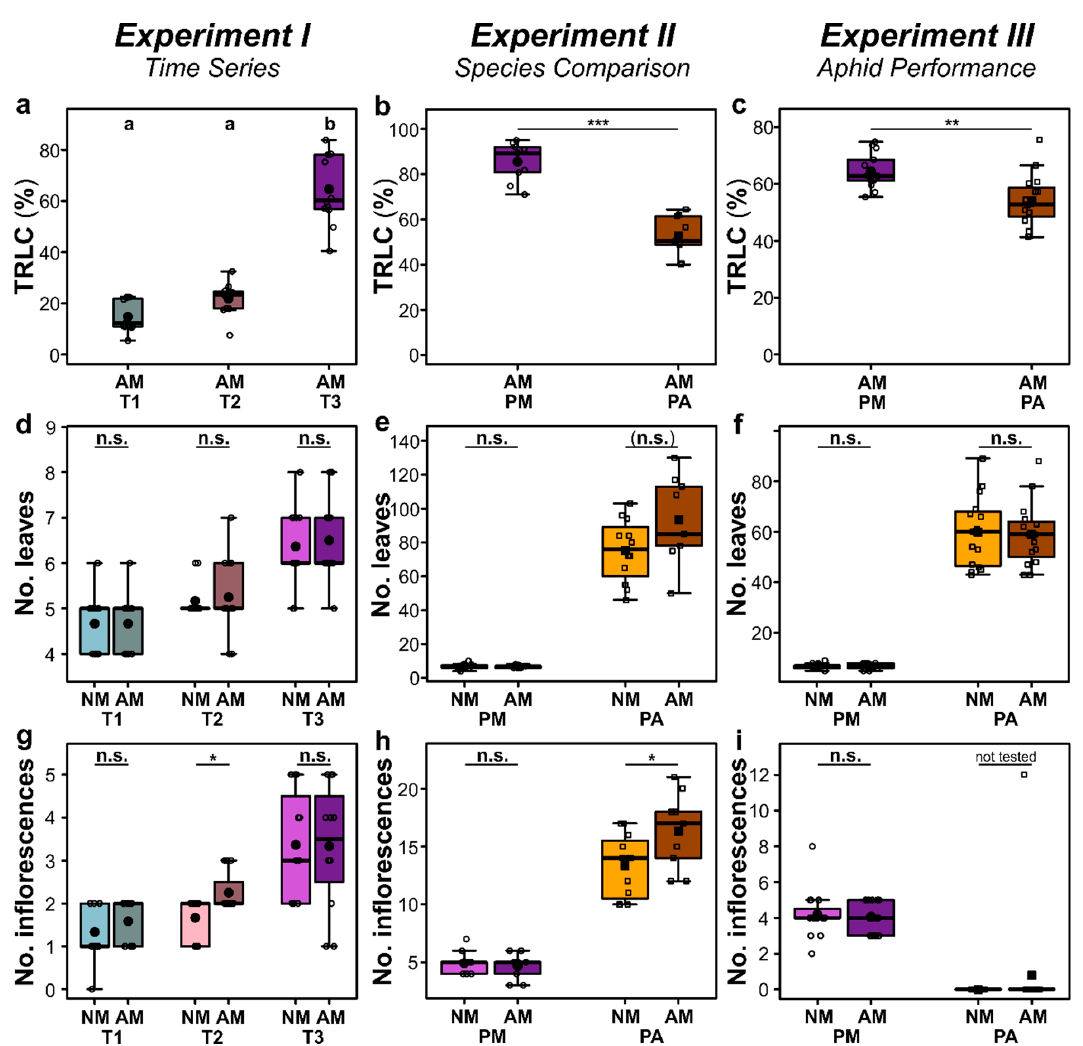
Figure 1. Total root length colonization (TRLC, first row), number of leaves (second row), and number of inflorescences (third row) of Plantago major (PM) and Poa annua (PA) plants that that have been left as controls (NM) or were inoculated with the arbuscular mycorrhizal fungus Rhizoglomus irregulare (AM). ( a , d , g ) Experiment I ( Time Series ) with P. major , showing data at the time points T1, corresponding to 20 days post inoculation (dpi), T2 (30 dpi), and T3 (63 dpi); ( b , e , h ) Experiment II ( Species Comparison ) with P. major and P. annua at 66–68 dpi (TRLC) and 64 dpi (numbers leaves/inflorescences); ( c , f , i ) Experiment III ( Aphid Performance ) with P. major and P. annua , showing TRLC at time points when all aphids had died on the individual plants or when the experiment was terminated, and numbers of leaves/inflorescences at 61 dpi (i.e., shortly before the aphid bioassay started). Data are given as box-whisker plots, with the medians given as horizontal thick lines, means as large filled symbols (circles: P. major ; squares: P. annua ), interquartile ranges (IQR) as boxes, raw data points as small open symbols (circles: P. major ; squares: P. annua ), and the whiskers extending to the most extreme data points within maximum 1.5 times the IQR. At the top of each subpanel, results of statistical tests are given: ( a ) different letters indicate significant differences of a post hoc Kruskal–mc test at p < 0.05, ( b – i ) asterisks indicate significant differences between groups [n.s., not significant; (n.s.) p < 0.1; *, p < 0.05; **, p < 0.01; ***, p < 0.001; ( b , c , f ) t -tests, ( d , e , g – i ) Mann–Whitney U -tests]. The sample sizes (biological replicates) were: n = 11–12 ( Experiment I ), n = 9–12 ( Experiment II ), n = 14–15 ( Experiment III